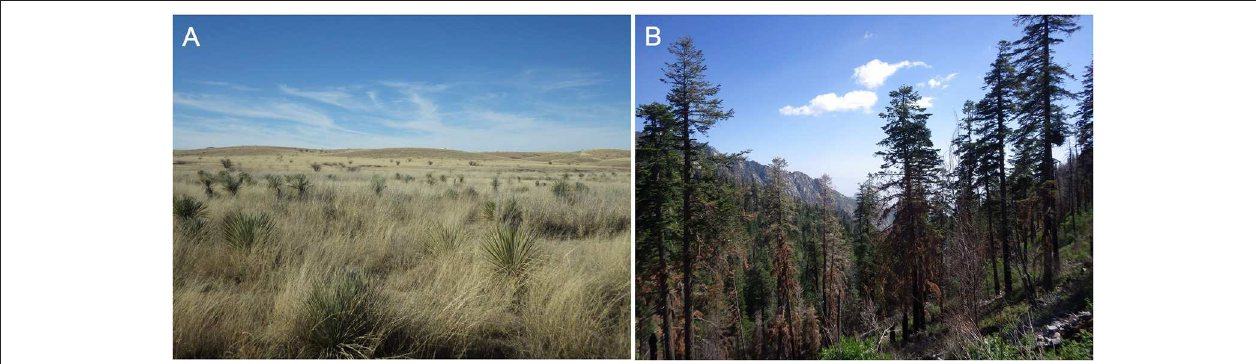
FIGURE 1 | Landscapes vary in complexity. Panel (A) shows a southern Arizona grassland at Las Cienegas National Conservation Area, illustrating a landscape with low taxonomic diversity, plant functional trait diversity, and topographic complexity. Panel (B) by comparison, has higher complexity, with a clear legacy of disturbance by wildfire, high plant functional diversity and topographic complexity, and more interactions among a higher number of species. Photo from Mount Graham, in the Pinaleño Mountains of Arizona. Ecosystems and ecology are shaped dynamically by bottom-up factors such as local topography, spatial clustering of resources, and stochastic events such as ignitions, as well as top-down processes and controls such as temperature, precipitation, and other climatic factors. Disturbances such as wildfire and insect outbreaks are influenced by these factors and others, including phylogenetic history of organisms and their disturbance adaptations, physical structure and demography of organisms, and landscape history. However, knowing all of this information perfectly is not sufficient to predict fire behavior, initial ignition points, or extent of insect-caused mortality, because the features of emergent phenomena (such as disturbance regimes) are highly sensitive to initial conditions and may not be deterministic. Photo credits: E.A.